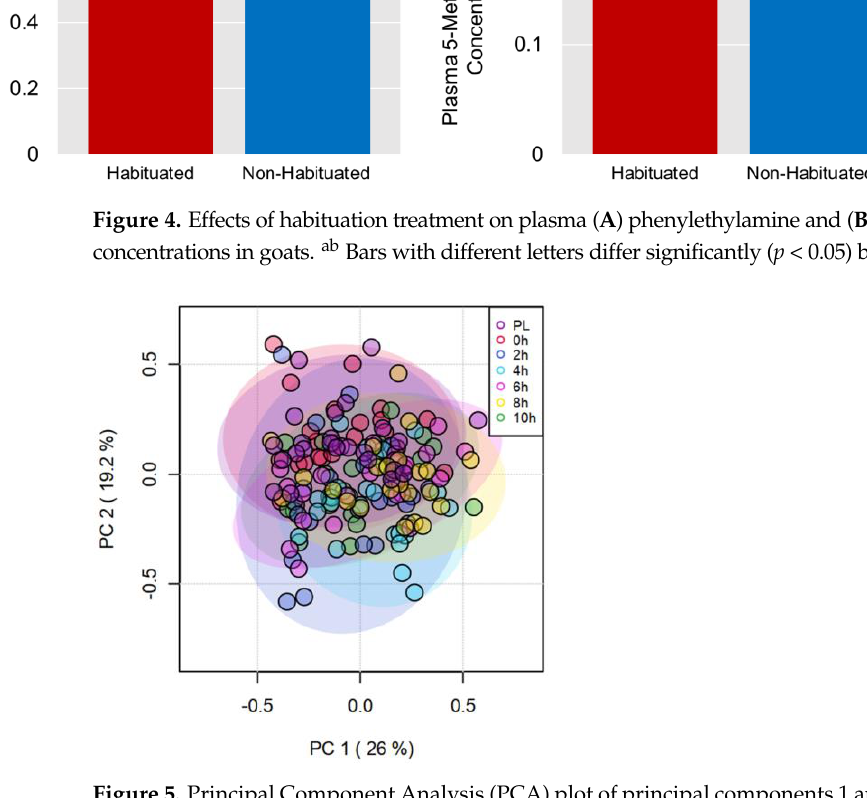
Figure 5. Principal Component Analysis (PCA) plot of principal components 1 and 2 of transportation time for catecholamines.